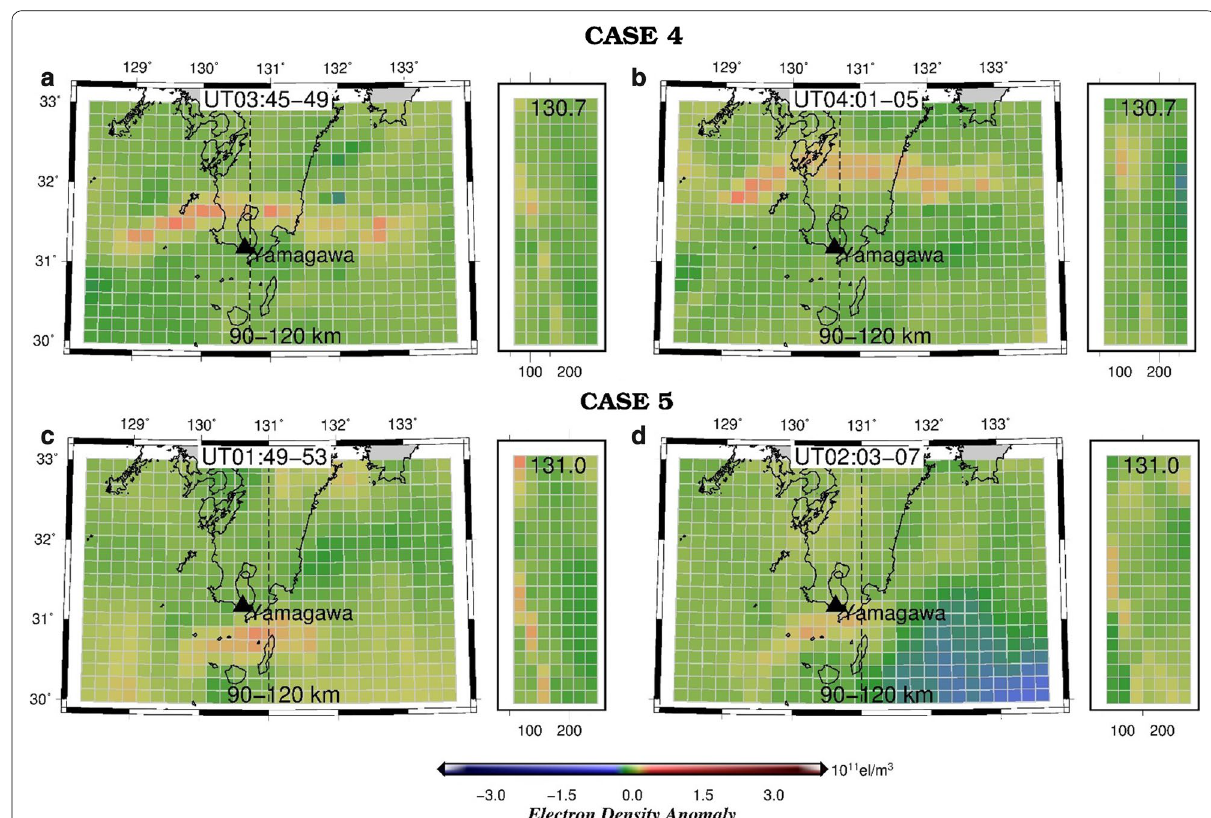
Fig. 9 Horizontal drifts of Es patches in two cases (Case 4: May 22, 2010, and Case 5: June 9, 2013) above the Kyushu District inferred by comparing the snapshots at the first epoch ( a , c ) and 15 min later ( b , d ). At each epoch, we show the map view (left) and the longitudinal profile (right). Black dashed lines indicate the longitudes used for the